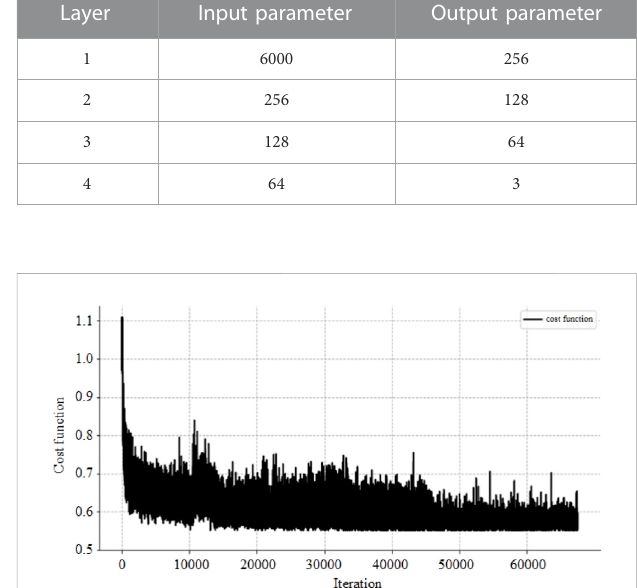
FIGURE 11 Cost function of SAE network.